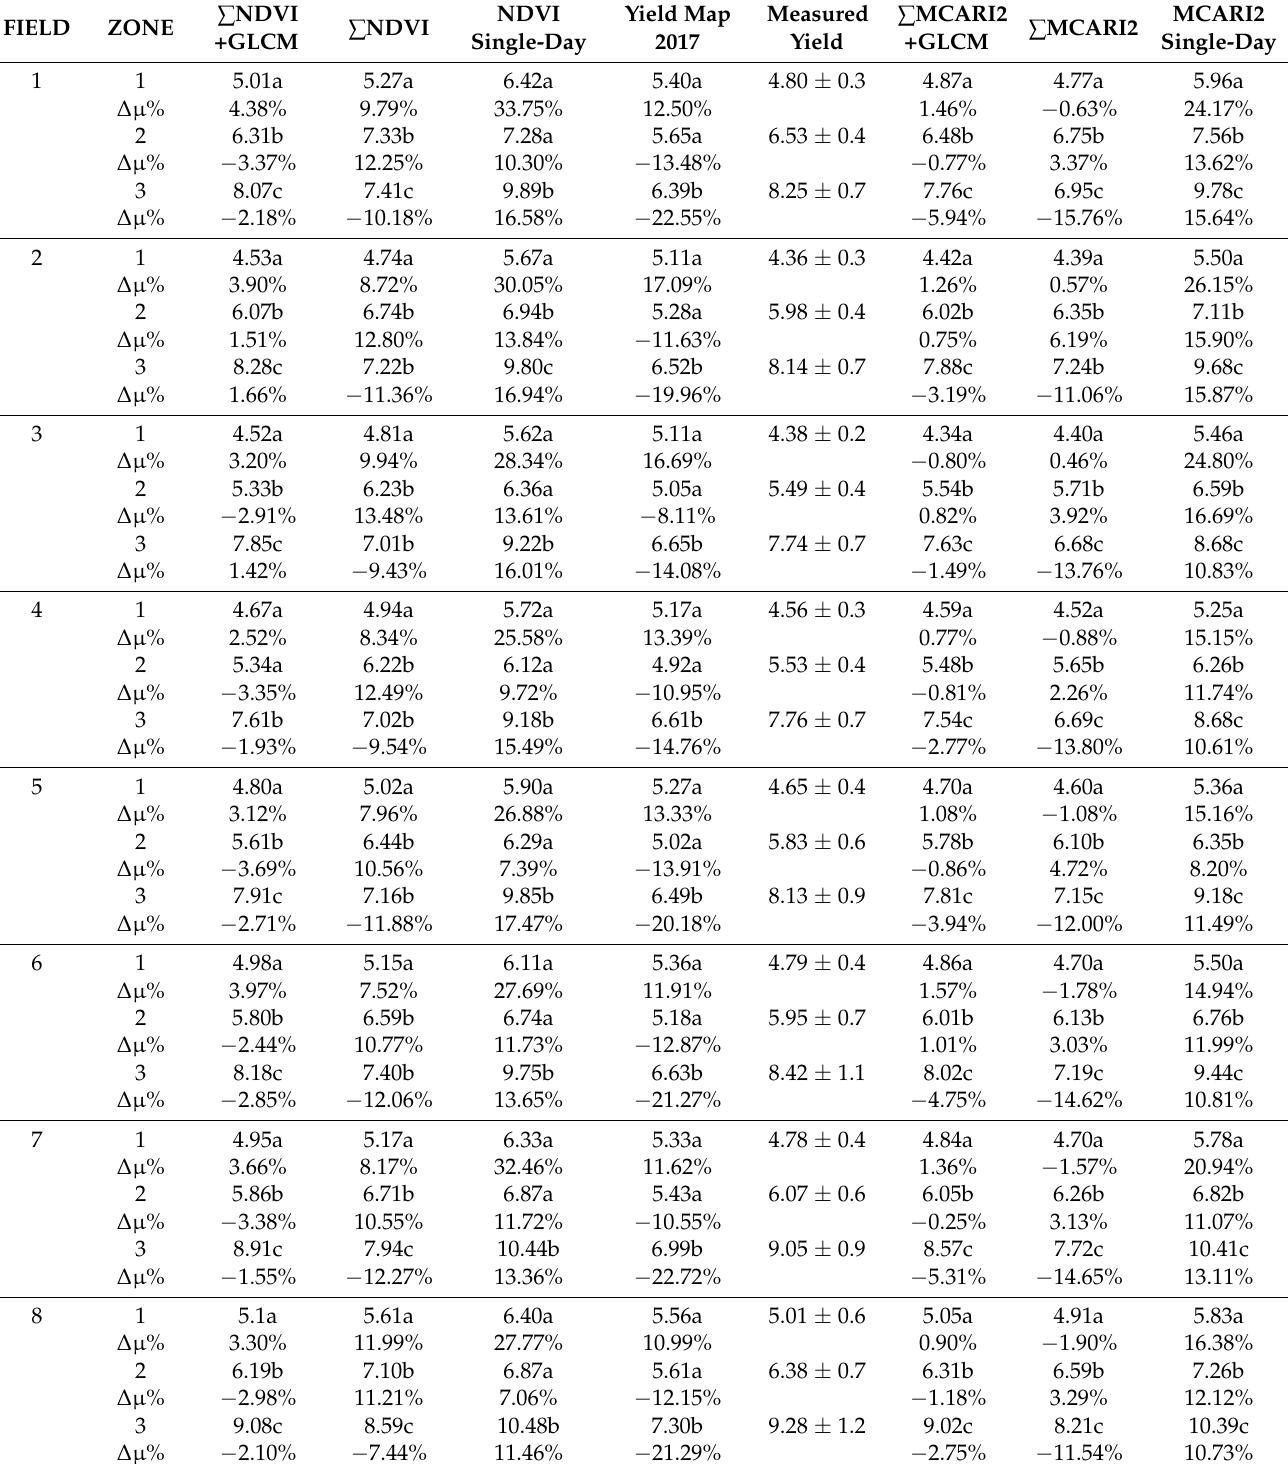
Table 8. Average of the two-year estimated values ( µ ), with standard deviation ( σ ) and range of the yield values (Mg ha − 1 ) of the areas intercepted by the seven clustering modes in ten fields. Different letters indicate significant differences at Tukey test ( p -value < 0.05) between the three clusters of the same